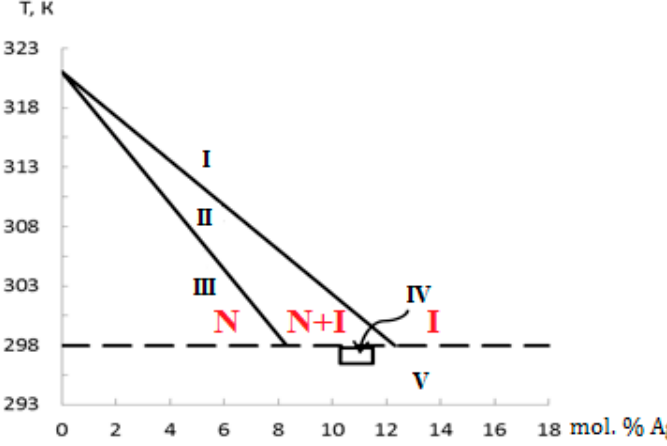
Figure 10. The scheme of phase-structural states for “Ag—4-cyano-4 ′ -pentylbiphenyl” hybrid nanosystem: I—isotropic phase; II—two phase region: isotropic phase including the fluctuations of nematic ordering; III—nematic phase; IV—the temperature region in nematic phase, which was close to phase transition from crystal to nematic; and V—solid phase at 150–200 К .